Question: Write a descriptive caption for this figure.
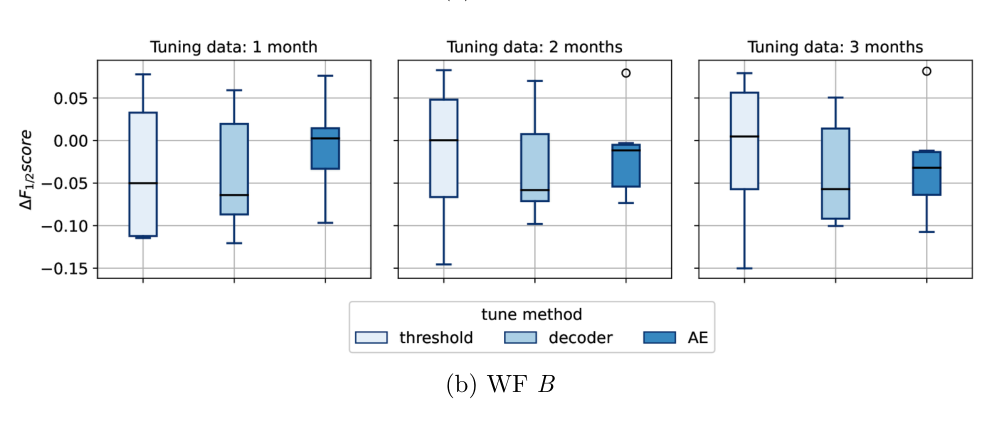
Answer: Transfer Learning results using data of multiple assets to train a source model and fine-tuning on the target wind turbine. The difference in F1/2 score with respect to the baseline model for each wind turbine is shown.